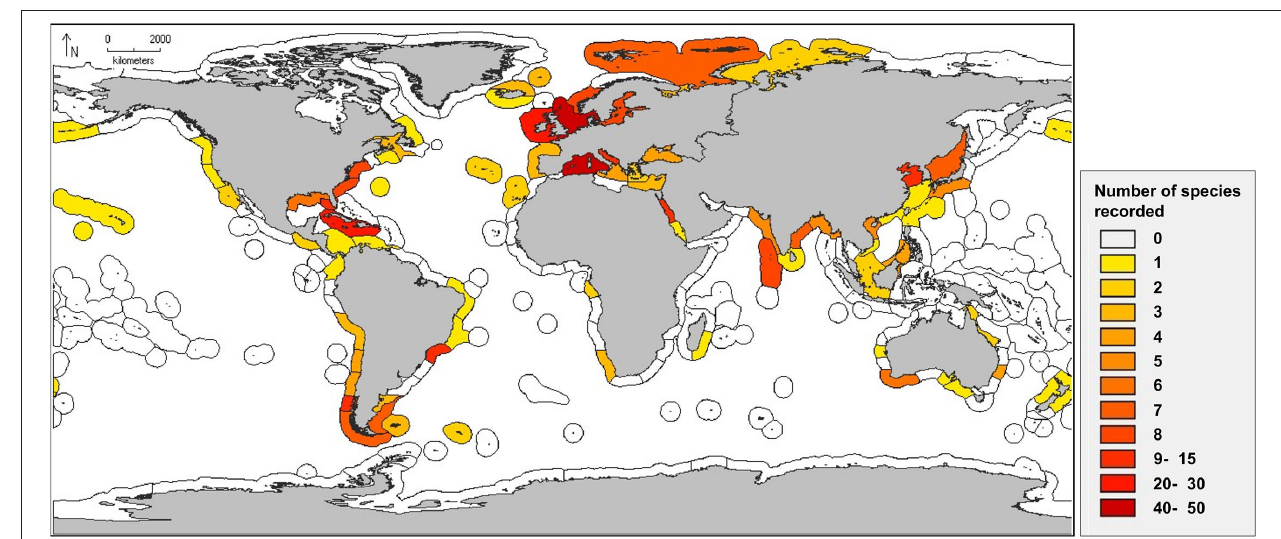
FIGURE 7 | World Map showing the marine ecoregions of Spalding et al. (2007) colored accordingly the number of Cyatholaimidae species recorded in each one.